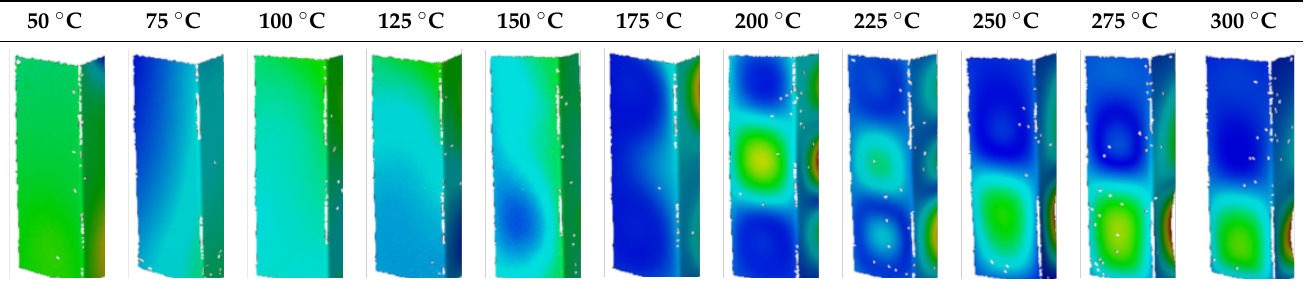
Table 7. Post-heating modes of channel section